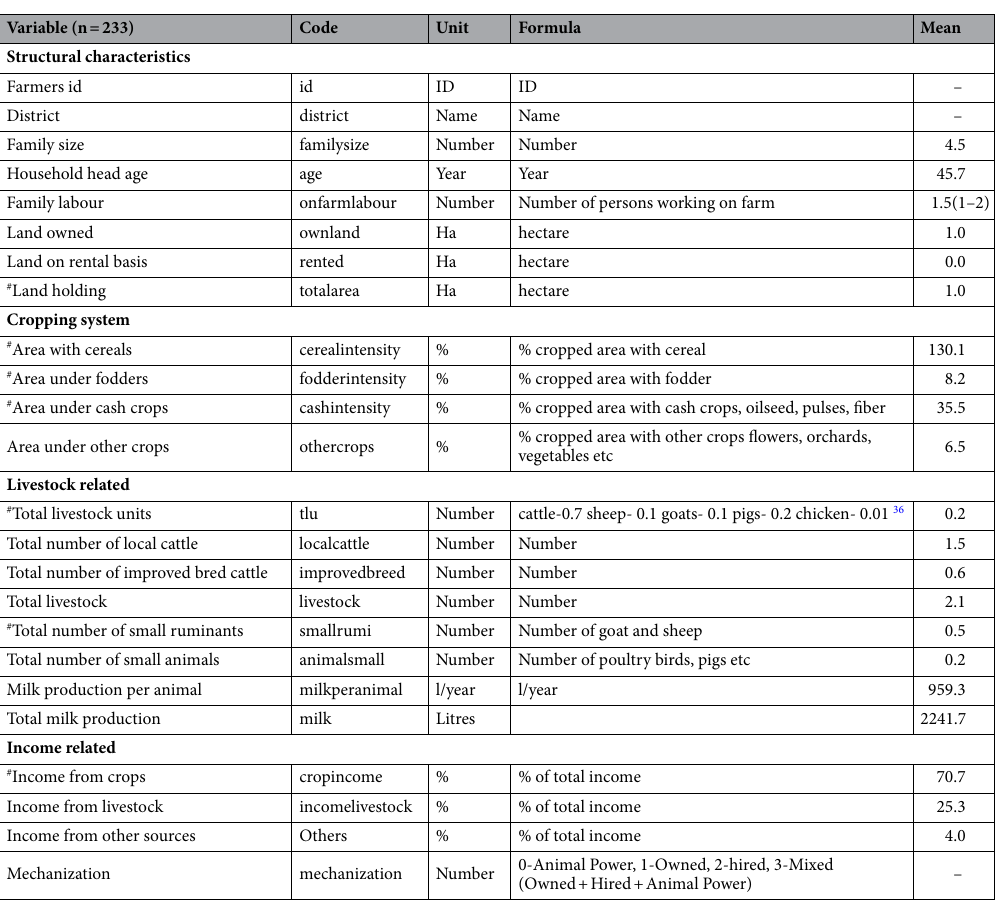
Table 1. Summary statistics for variables used for categorizing farm households. # Variables selected for PCA after correlation